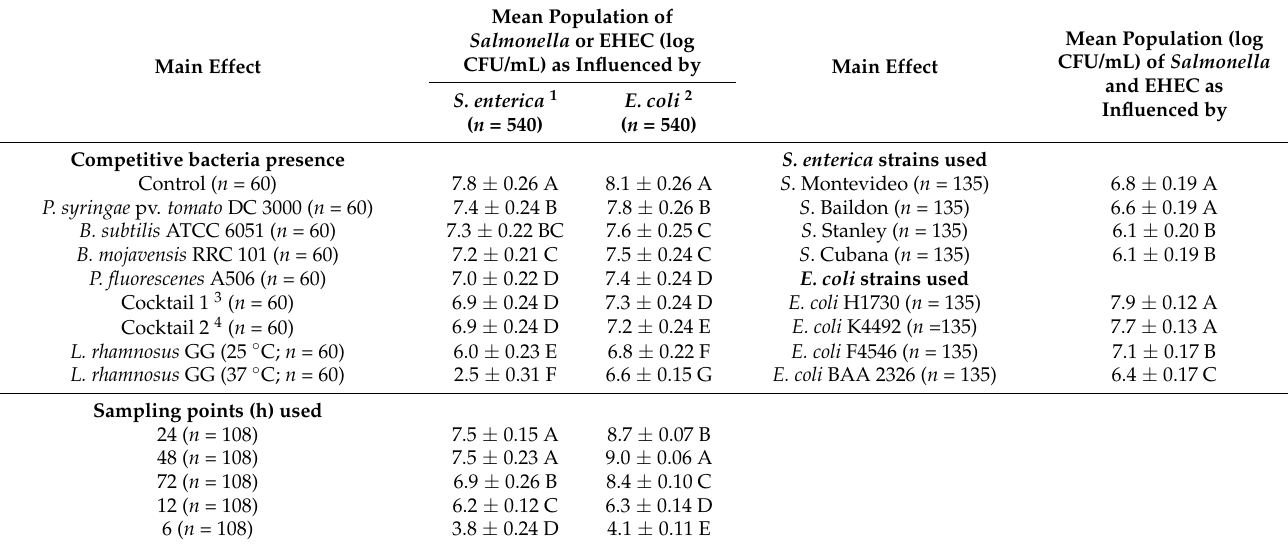
Table 2. Overall mean S. enterica and EHEC populations in co-cultures with different competitive bacterial strains and at different sampling